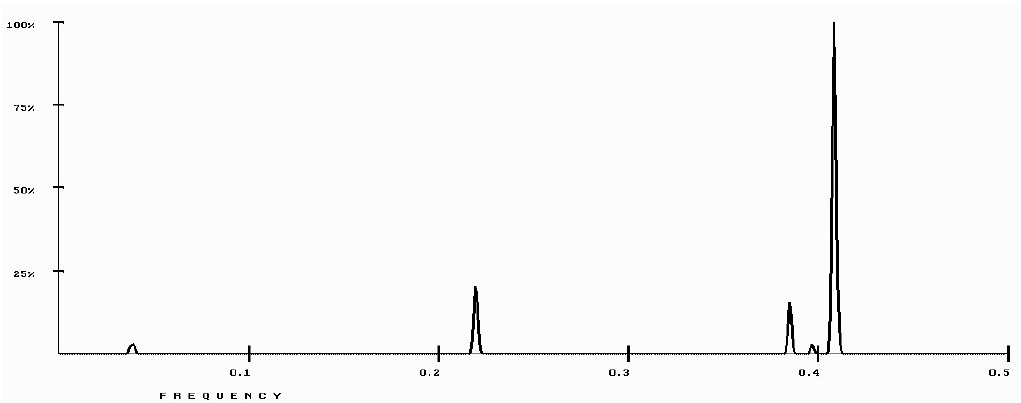
Figure 1. Resonant Recognition Model (RRM) cross-spectrum of parathyroid hormone proteins. The prominent common characteristic frequency for these proteins is at f1 = 0.4072 ± 0.0108, which represents an electromagnetic radiation wavelength of about 502 nm.